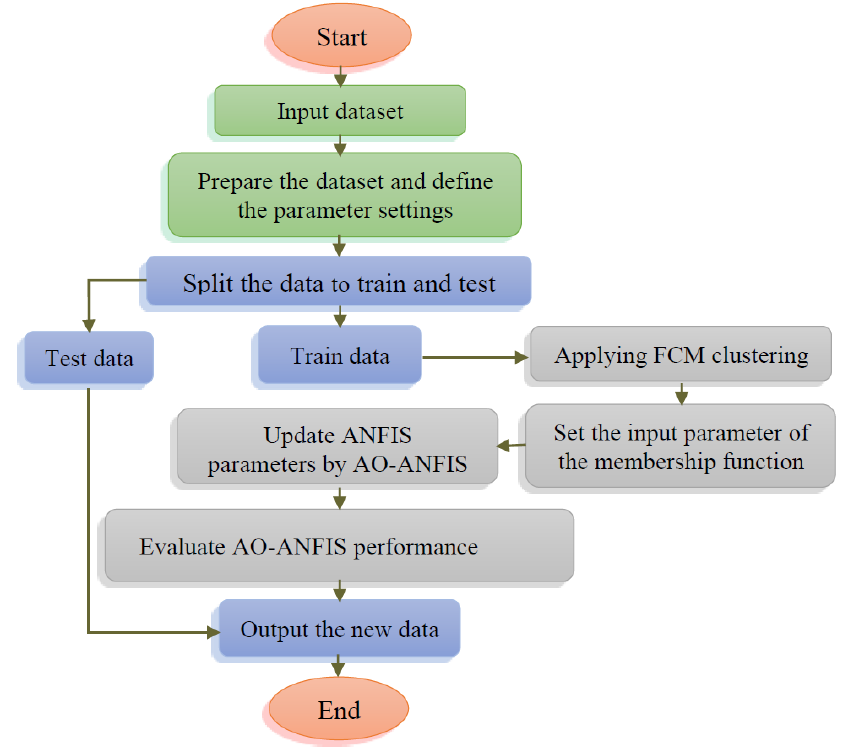
Figure 2. The workflow of the proposed